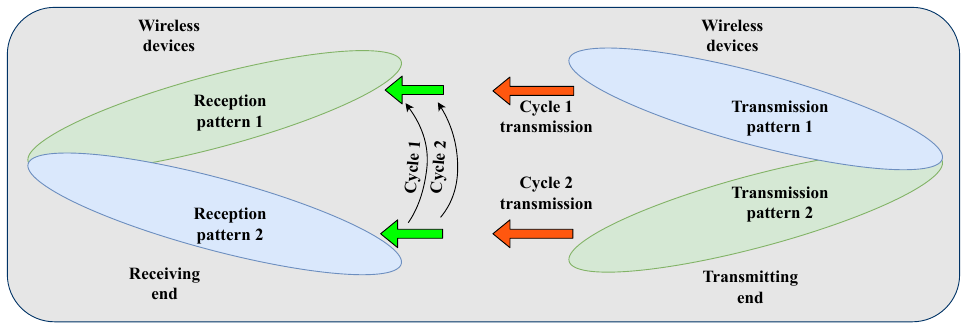
Figure 2. Single-link